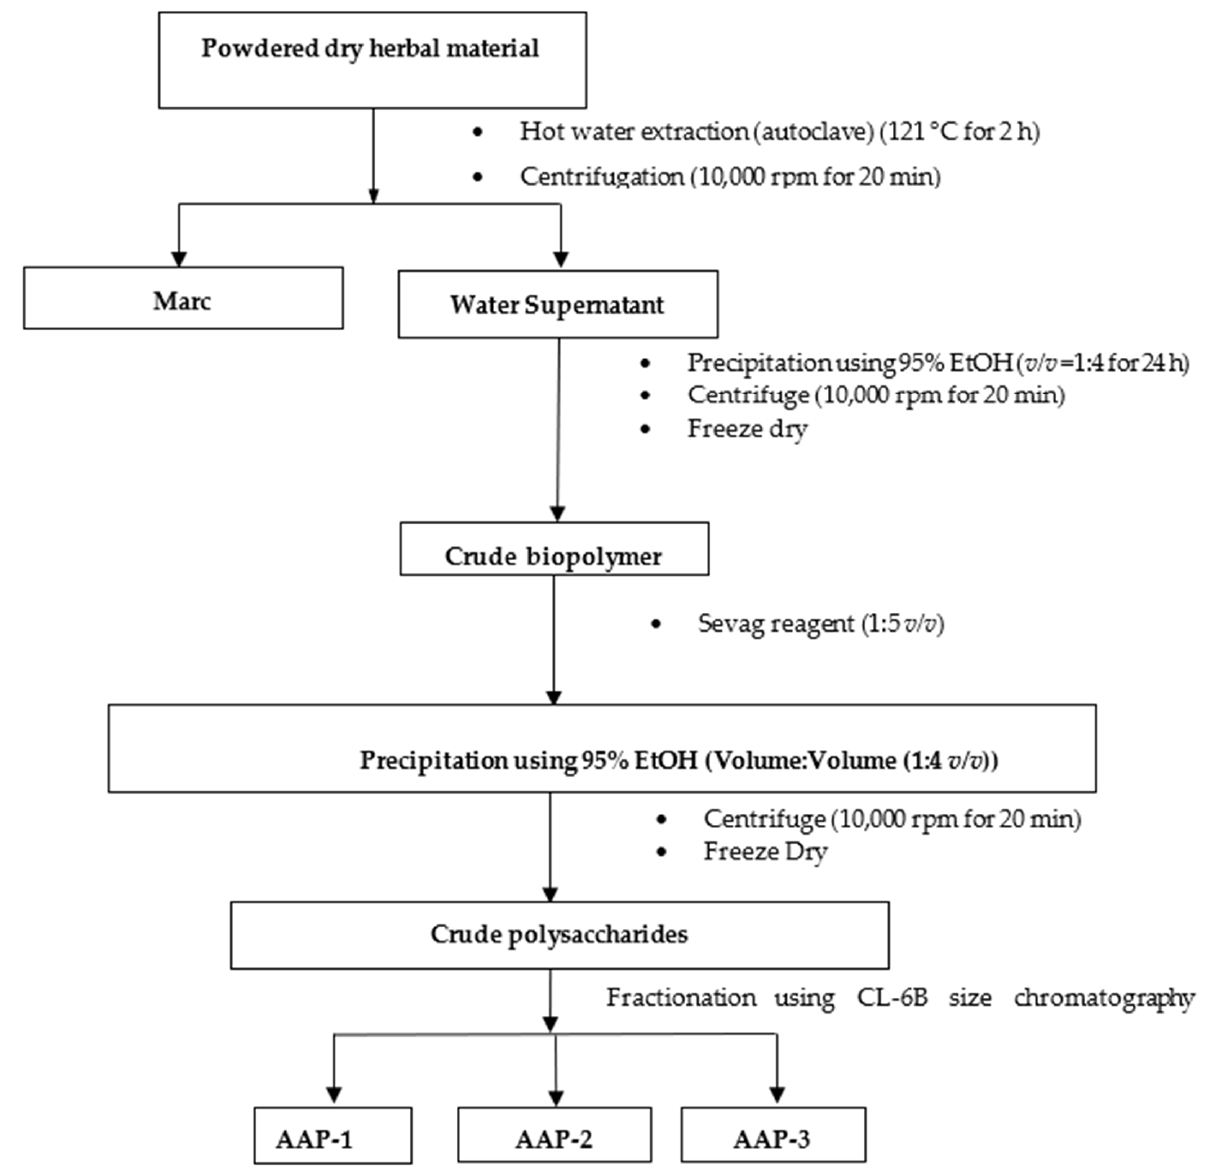
Figure 1. Flow chart for the extraction of polysaccharides from A . annua [21,32].